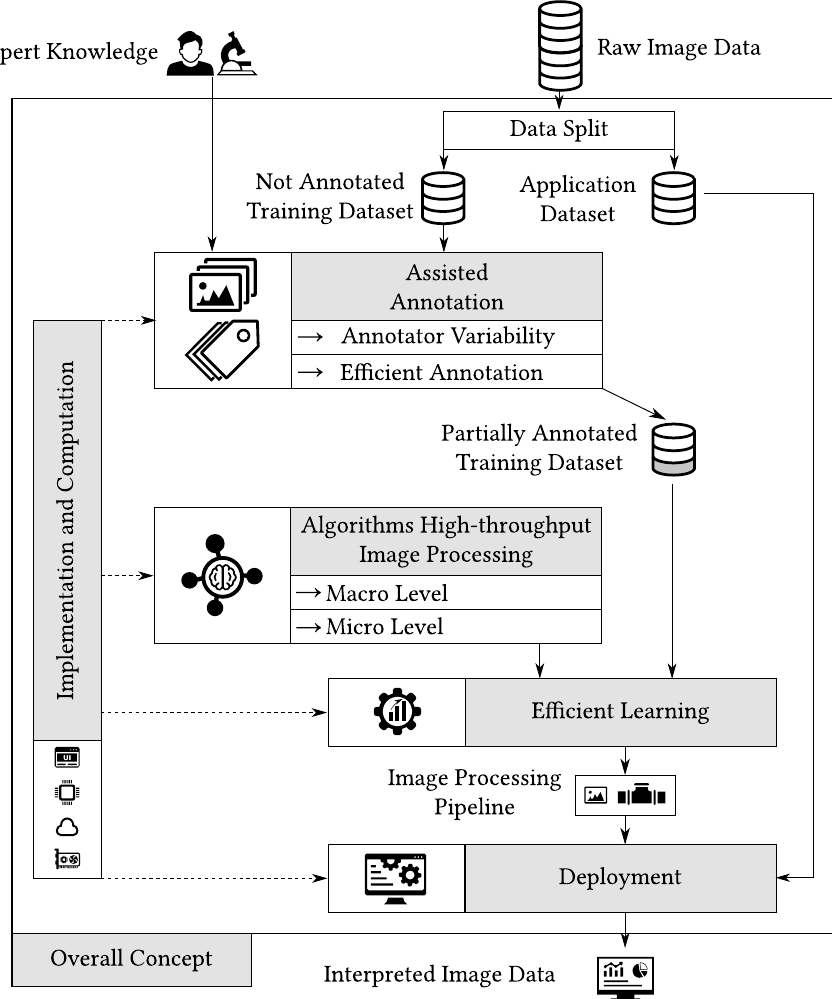
Figure 3. Overall Concept for Information and Data Processing. Raw image data is split into an application dataset and not annotated training dataset. Considering efficiency and annotator variability, a partially annotated training dataset is then created using expert knowledge. The partially annotated dataset is the starting point for parameterizing the developed algorithms for high-throughput image processing, considering both